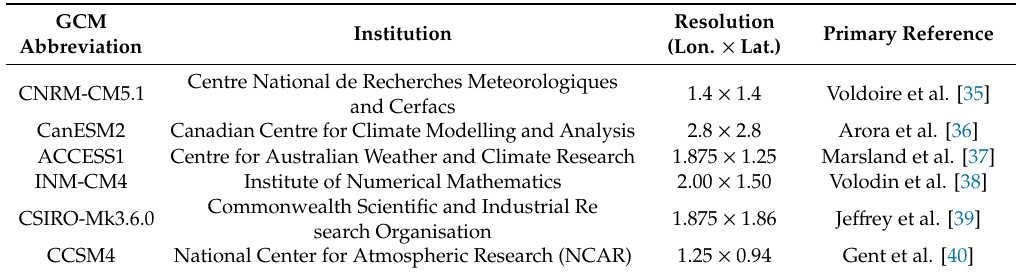
Table 1. The select set of six Global Climate Models (GCMs) from the coupled model inter-comparison project (CMIP5) experiment employed in this